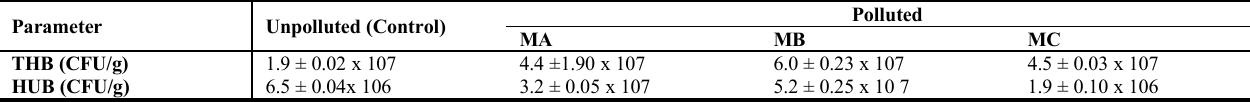
Table 2: Bacterial count of soil samples contaminated with waste engine oil.